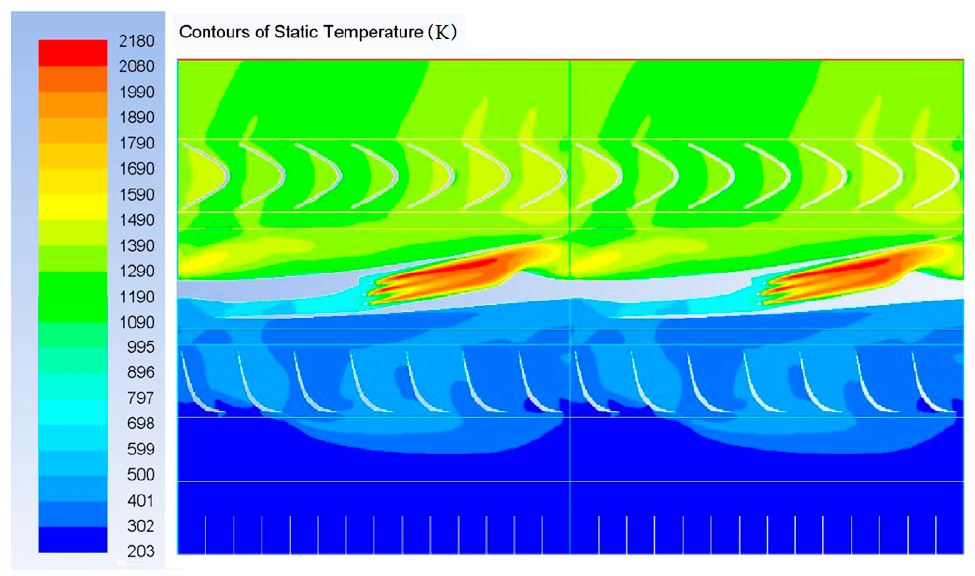
Energies 2020 , 13 , x FOR PEER REVIEW Figure 27. Contours of static temperature inside the engine channels. Figure 27. Contours of static temperature inside the engine channels.